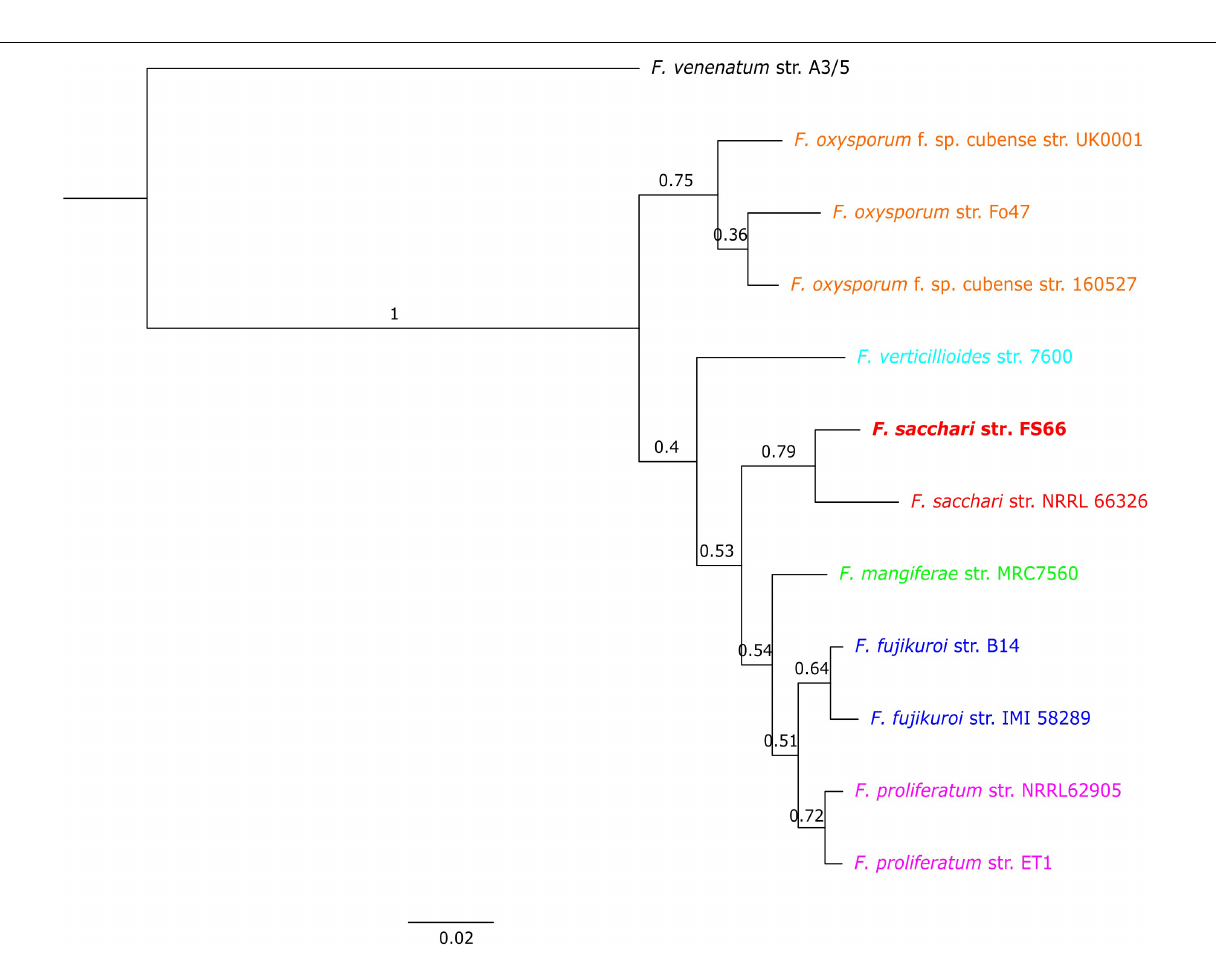
FIGURE 4 | The best supported phylogenetic tree based on whole-genome proteins of FS66 and several adjacent Fusarium species. The species tree has been constructed based on the 9050 orthogroups, which include members from all the analyzed genomes. The lengths of the branches are proportional to genetic distance. The number on top of the branches denote the bipartition’s support rate at their right ends, which is the proportion of orthogroups supporting the bipartition. The number below each branch indicates the number of identified gene duplication